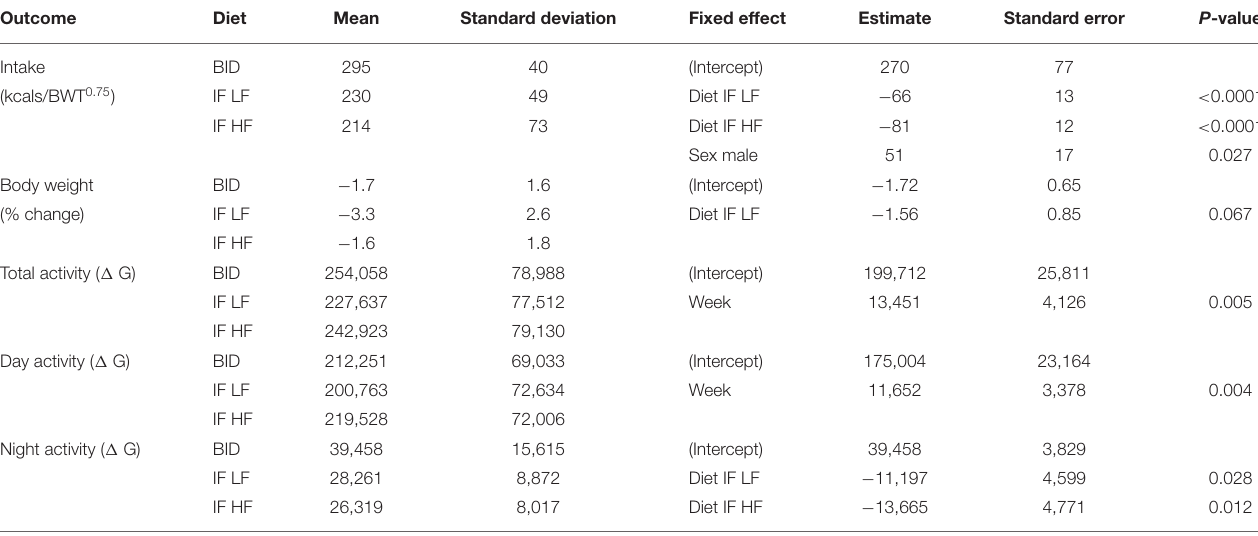
TABLE 2 | The means and standard deviations of food intake, change in bodyweight, and activity in 10 dogs fed daily (BID), and intermittently fasted on a low fat (IF LF) and a high fat diet (LF HF) in a Latin Square design.